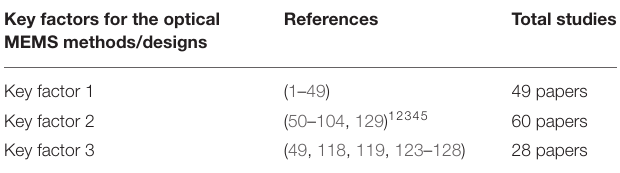
TABLE 4 | Critical factors of optical